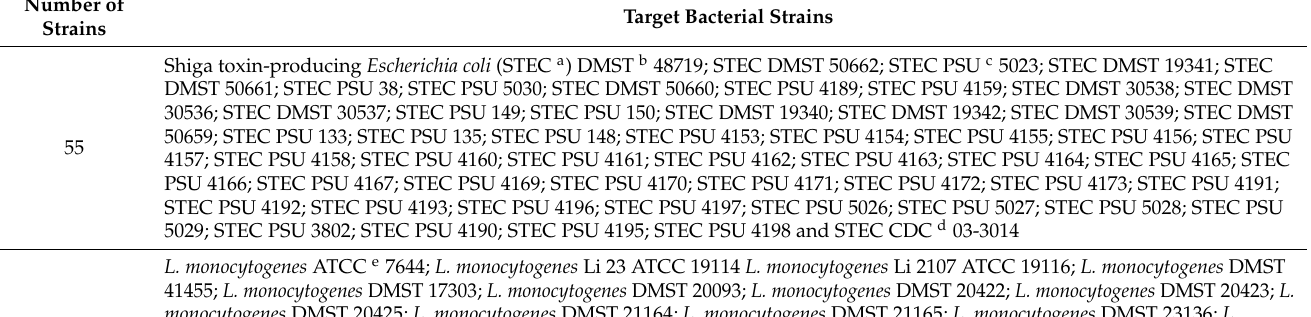
Table 1. Target bacterial strains used for inclusivity of the developed mPCR